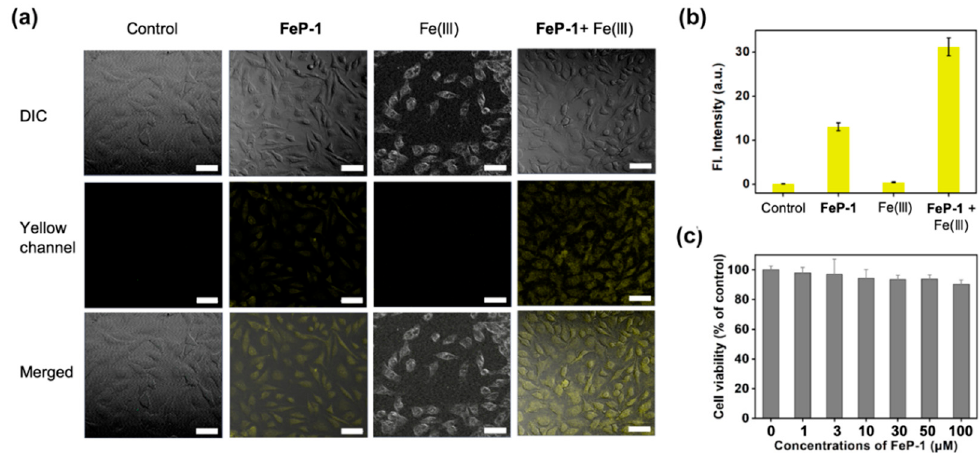
Figure 3. ( a ) CLSM images of the FeP-1 (50 μ M) in HeLa cells (magnification, × 20). Control: cells only; FeP-1 : cells with the FeP-1 (50 μ M) incubated for 2 h; Fe(III): cells with the Fe(III) (50 μ M) incubated for 2 h ; FeP-1 + Fe(III): cells pretreated the FeP-1 (50 μ M) for 2 h and then incubated with FeCl 3 (50 μ M) for 2 h. Excitation wavelengths 450 nm, and detection wavelengths channel were 455–600 nm, respectively. Scale bar is 20 μ m. DIC: bright field, Yellow channel: fluorescence detection channel (455–600 nm), Merged: superimposed image of DIC and yellow channel. ( b ) The relative fluorescence intensity shown in panel (a). ( c ) Cell viability of FeP-1 . Cells were incubated with 0–100 μ M of FeP-1 for 24 h in HeLa cells.